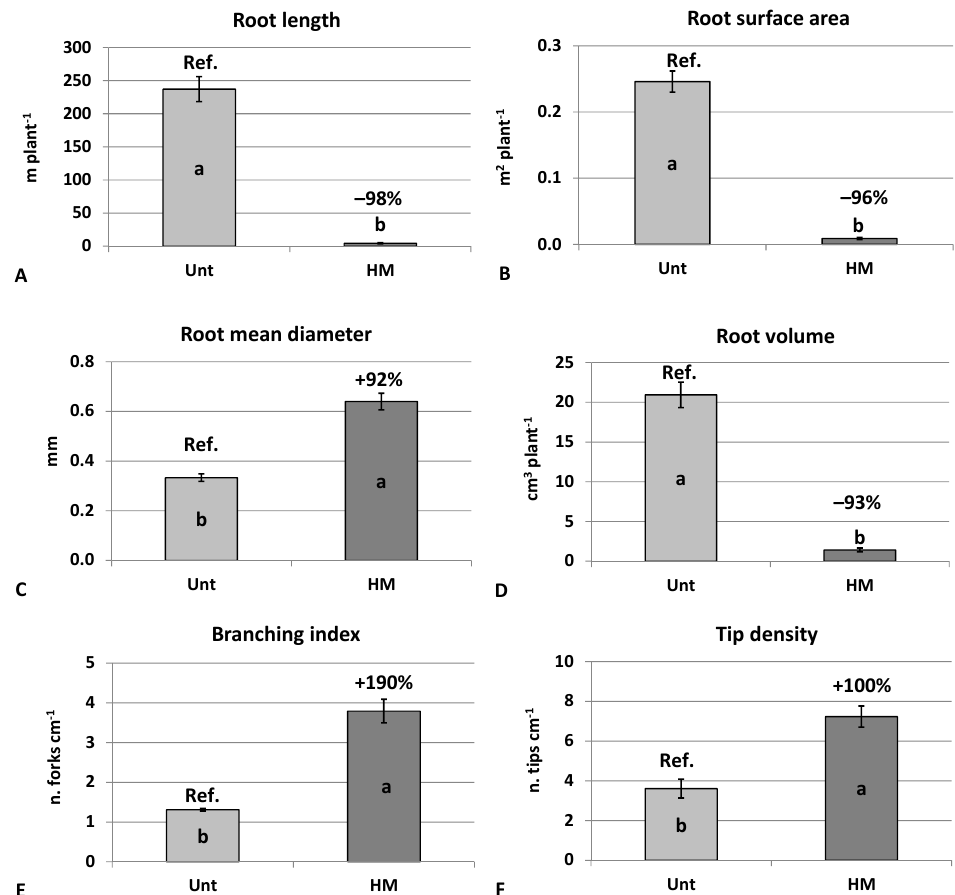
Figure 2. Main root parameters, i.e., length (cm plant − 1 ) ( A ), surface area (cm 2 plant − 1 ) ( B ), mean diameter (mm) ( C ), volume (cm 3 plant − 1 ) ( D ), branching index (number of forks cm − 1 ) ( E ), and tip density (number of tips cm − 1 ) ( F ) of the maize hybrid Naudi, grown for 41 days in uncontaminated (Unt) vs. metal contaminated (HM) soil. Numbers above the histograms refer to the % variations vs. Unt. Letters indicate significant differences between treatments (Newman–Keuls test, p ≤ 0.05).